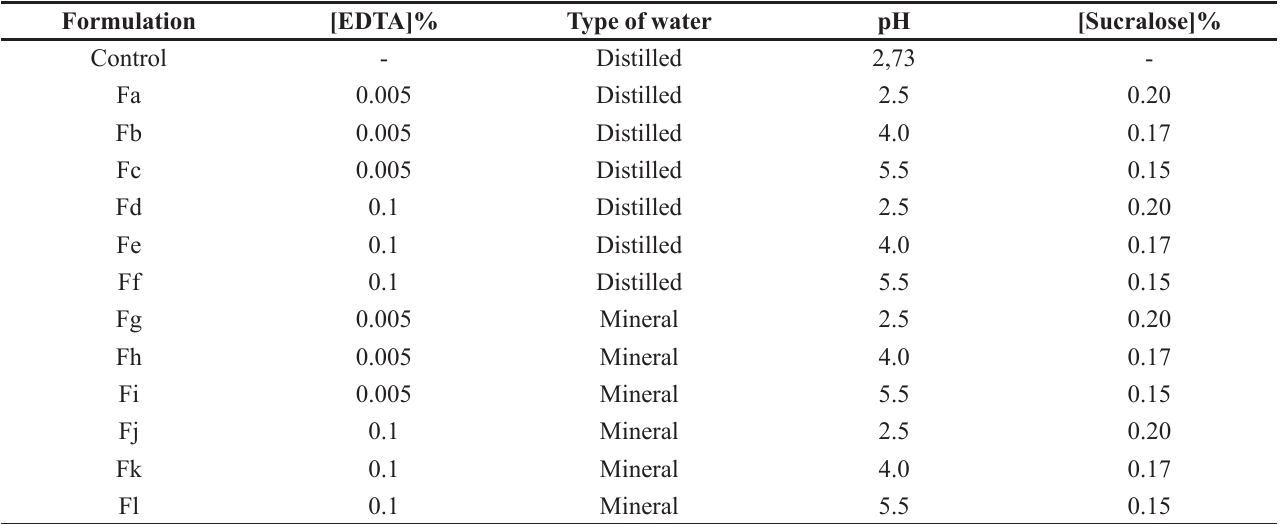
TABLE I - Formulations combining variables at different levels submitted to stress testing at 60 °C